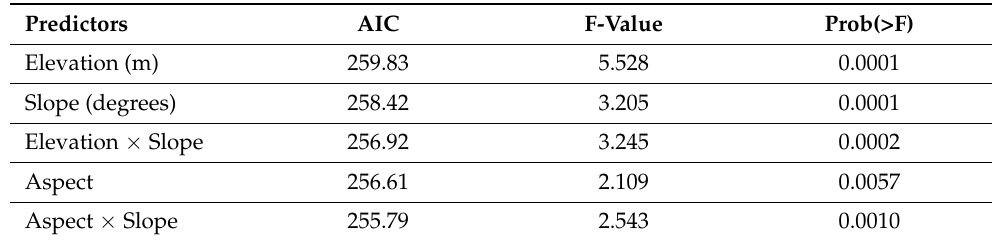
Table 7. Output of the forward selection of site variables and their interactions in the partial db- RDA, conditioned by the factor ‘Region’, involving all the 89 relev é s under study. Elevation was square-rooted prior to analysis.